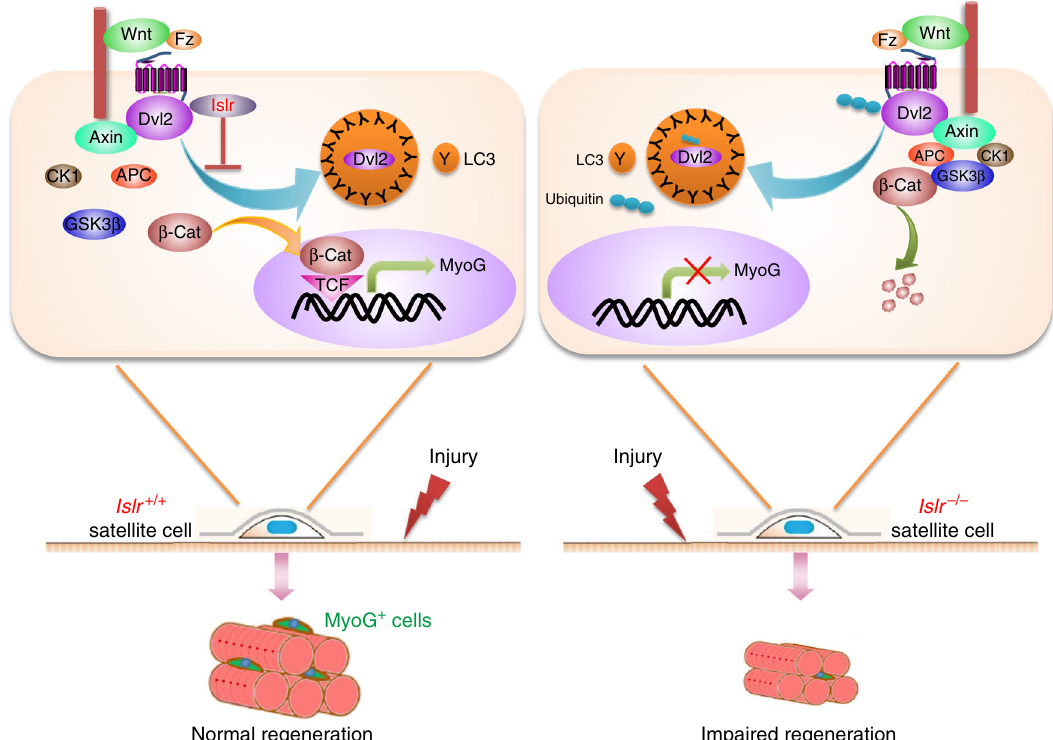
Fig. 10 Model of the role of Islr during adult skeletal muscle regeneration. Islr protects Dvl2 against autophagy-mediated degradation, resulting in the precise regulation of canonical Wnt signaling during skeletal muscle regeneration. Islr + / + : control mice; Islr − / − : Islr cKO